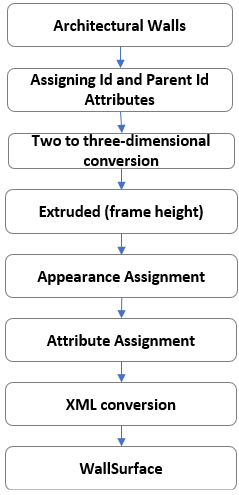
Figure 3. Creation of the CityGML model